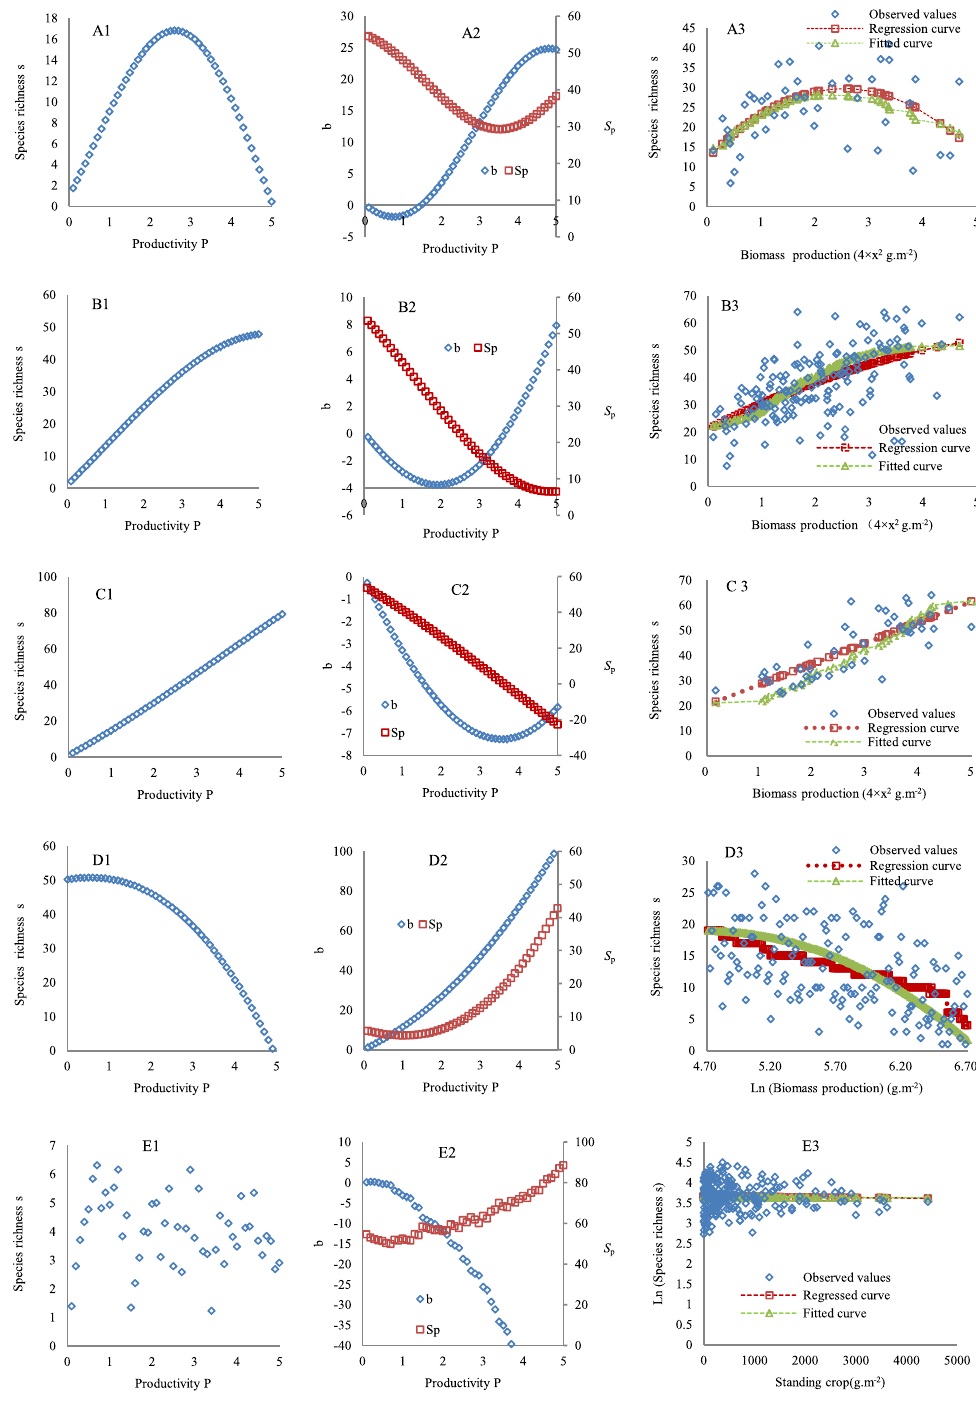
Figure 1. Typical forms of the PSRR. ( A1 – E1 ) represent the humped, asymptotic, positive, negative, and irregular forms, respectively. ( A2 – E2) show the dynamics of IICE ( b ) and the potential species-pool effect ( S p ) for the five forms. ( A3 – E3 ) show the observed species richness along a productivity gradient at local sites in Germany, the Czech Republic, Russia 38 , the USA 57 , and Australia 58 , respectively. Regression curves were fitted based on the observed species richness. Fitted curves were drawn using the predicted species richness (obtained using the second value in each cell in the data columns marked with # in Supplemental Table 1 being substituted into Eq.